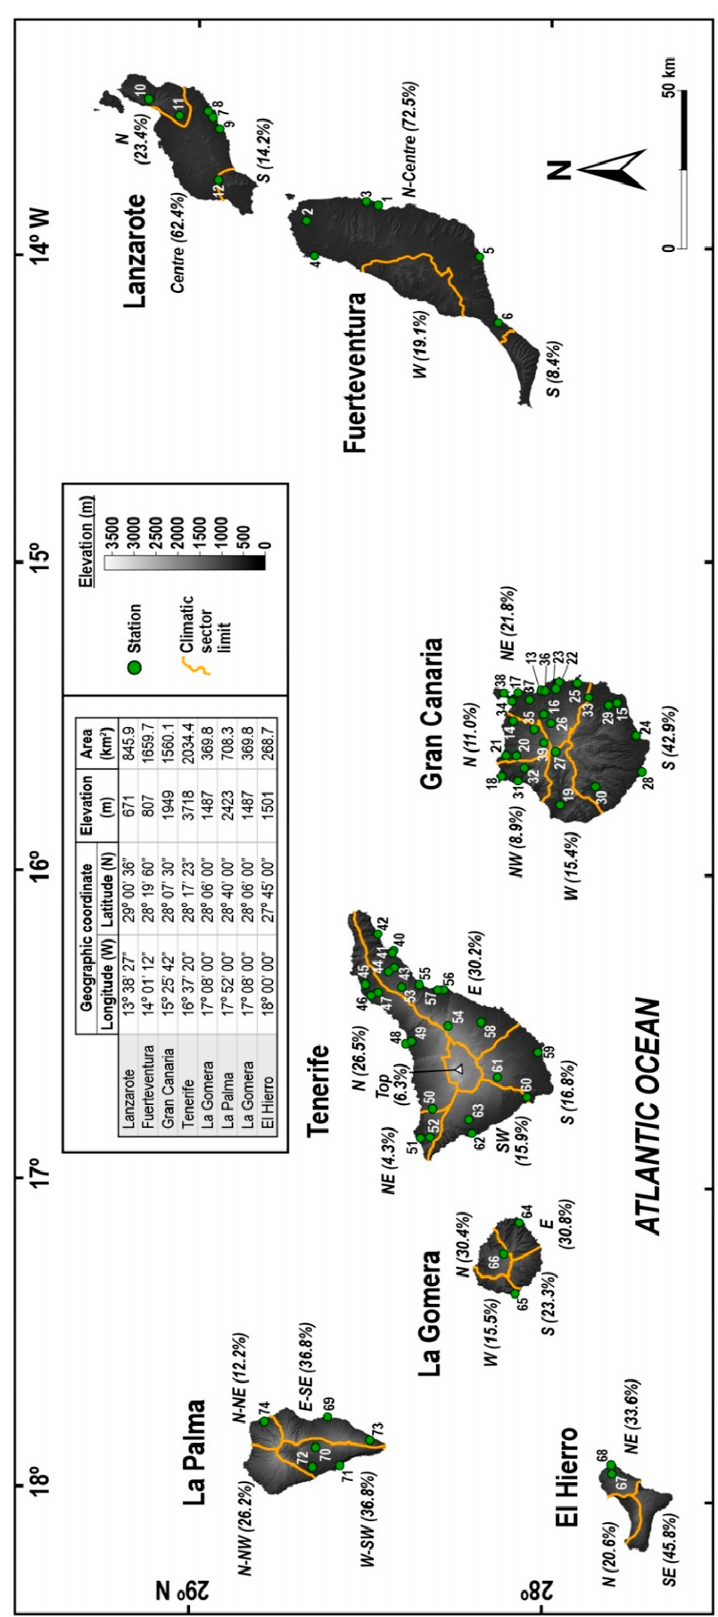
Figure 2. Subdivision of Canary Islands into local climate sectors (adapted from [24]), and location of the 74 corrosion exposure sites (see Table S1 in Supplementary Material for codes and local orography details).